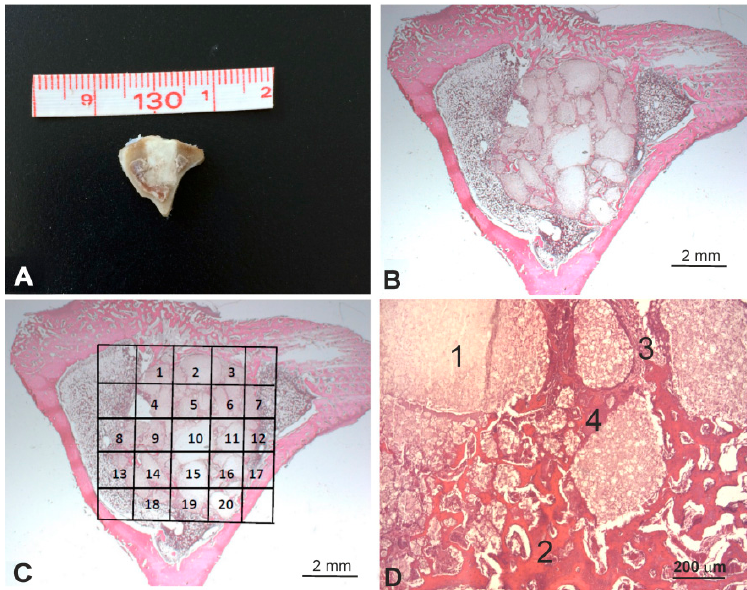
Figure 2. ( A ) Representative image of the macroscopic appearance of the implanted scaffold, ( B ) microscopic appearance of the implant stained with hematoxylin and eosin, ( C ) manually traced individual regions of interest (ROIs) by including only the scaffold, and ( D ) the four different components analyzed in the histomorphometric analysis (1, residual scaffold; 2, neoformed bone; 3, connective tissue; and 4, fibroblastic tissue). Hematoxylin and eosin stain ( B – D ).